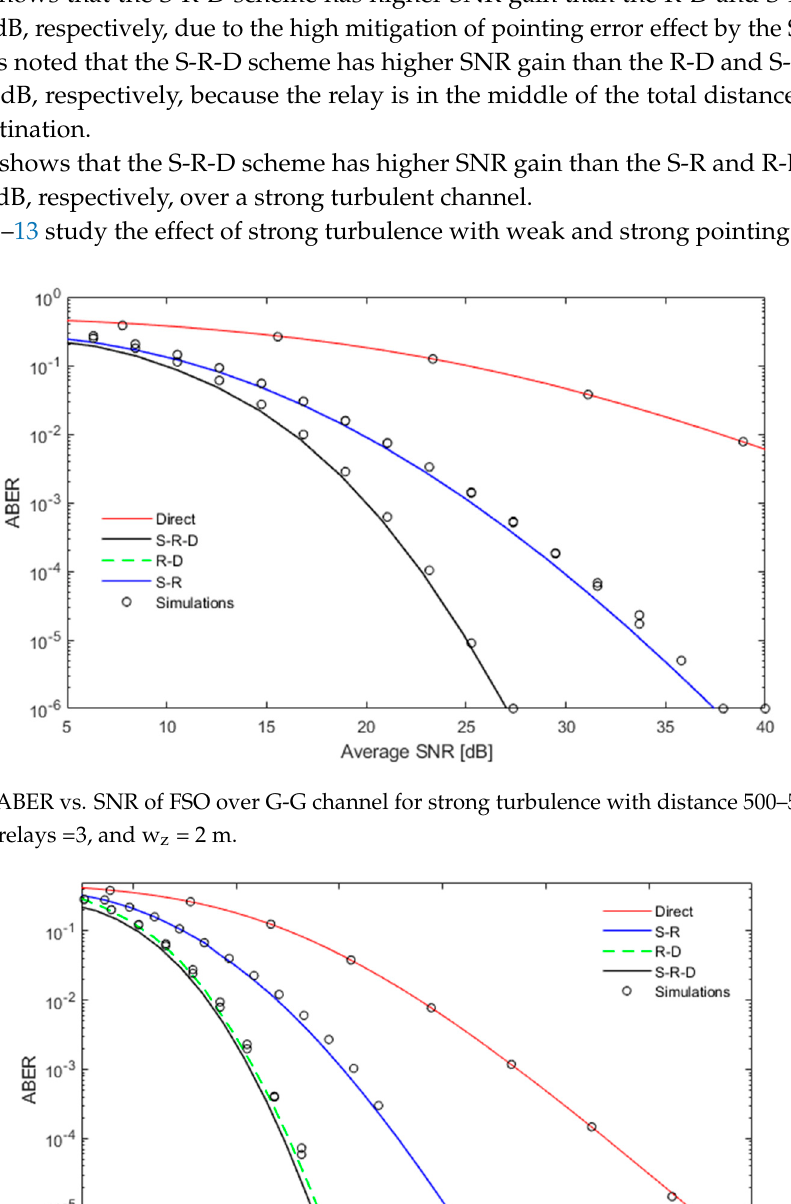
Figure 12. ABER vs. SNR of FSO over the Gamma-Gamma (G-G) channel for strong turbulence with distance 400–600 m, the number of relays = 3 and w z = 2 m.